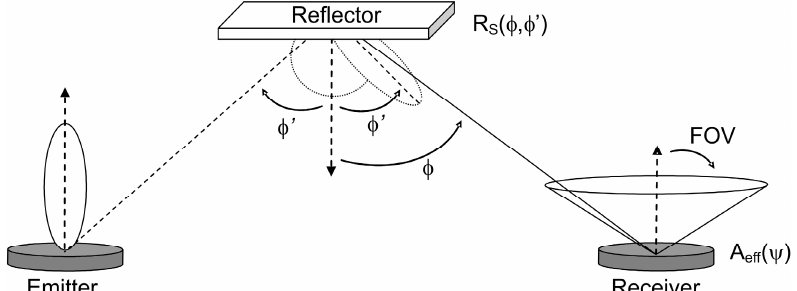
Figure 2. Emitter and receiver geometry with reflector. Reflection pattern of the surface is described by Phong’s model.